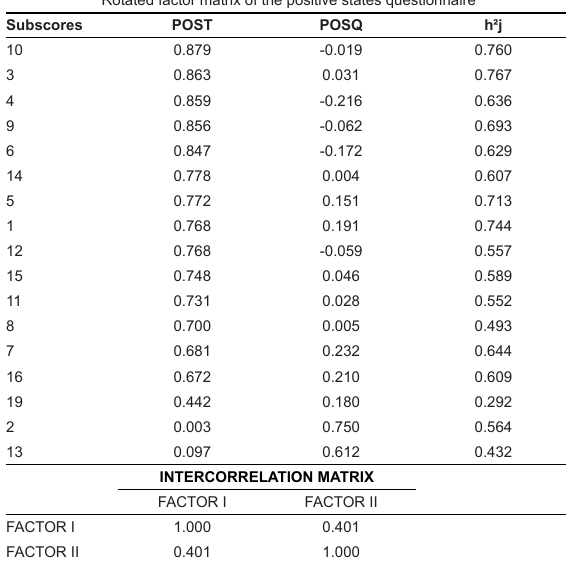
TABLE 3 Eigenvalues of unreduced intercorrelation matrix (17x17) positive states Factor II (POSQ). EM is also highly correlated with POM. In order to determine whether the two instruments were correlated, a regression was performed. The results of the relationship between EI and the two PSQ factors, POST and POSQ, are given in Table 8. Table 8 shows that a multiple correlation of 0.796 was obtained. This coefficient is statistically highly significant ( F (2.190) = 164,382; p = 0.001) and means that approximately 63 % of the variance of the criterion (EI) is accounted for by the predictors (adjusted R 2 = 0.630); B is the unstandardised regression coefficient, with SE B the standard error of B . Beta is the standardised regression coefficient and indicates that POST has by far the greater weight ( Beta = 0.708) and POSQ has almost no significance ( Beta = 0.112) for EI. Table 9 shows the relationship between EP and the two PSQ factors, POST and POSQ. A multiple correlation of 0.771 was obtained; R 2 = 0.595, adjusted R 2 = 0.591 implies that about 59 % of the variance is shared by the criterion and the predictors (almost 60 % ), which is also statistically highly significant ( F (2.190) = 139.557; p = 0, 001). All the regression coefficients are statistically significant indicating a strong relationship between the two instruments. Beta indicates that POST has by far the TABLE 4 greater weight ( Beta = 0.826) and POSQ has almost no weight Rotated factor matrix of the positive states ( Beta = -0.090) for EP. Table 10 reflects the relationship between the overall entrepreneurship orientation scale and POST and POSQ. This indicates a multiple correlation of 0.821, with R 2 = 0.675 and adjusted R 2 = 0.671, indicating a common variance of 67 % between the predictors and the criterion. Beta indicates that POST has a much higher weight ( Beta = 0.827) than POSQ,